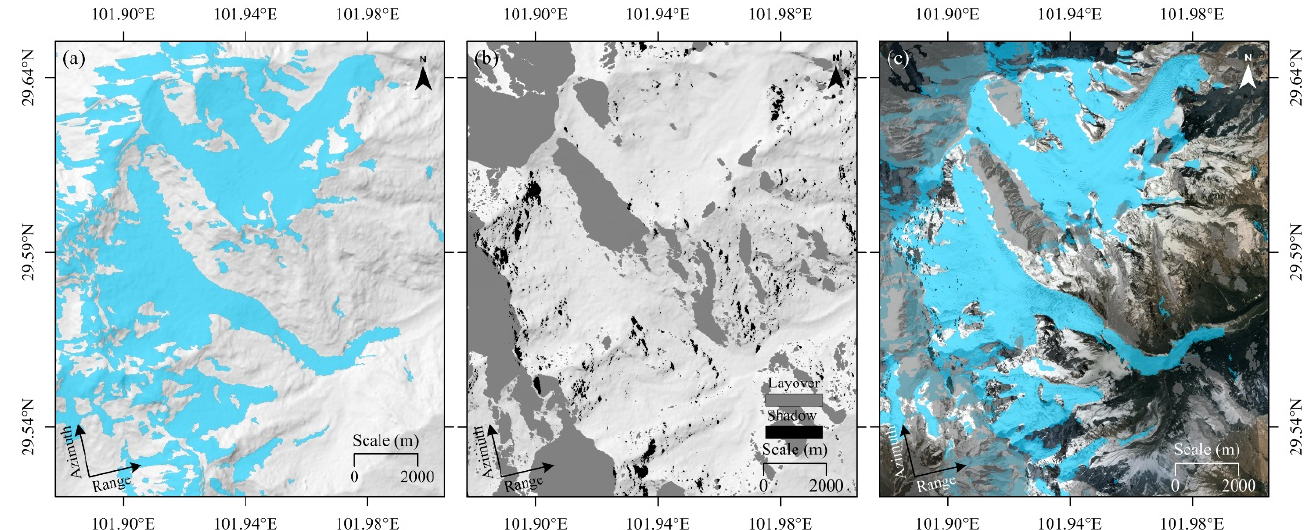
Figure 6. ( a ) Geocoded binarized ACR map in the WGS-84 geographic coordinate system; ( b ) layover-shadow map, and ( c ) geocoded binarized ACR map and layover-shadow map with 50% transparency superimposed on a Google Earth optical image.